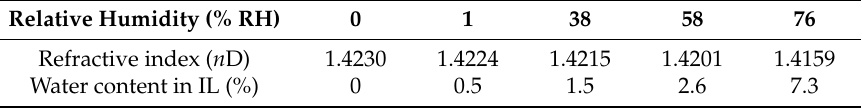
Table 1. Water content in IL at various humidity calculated from refractive index.